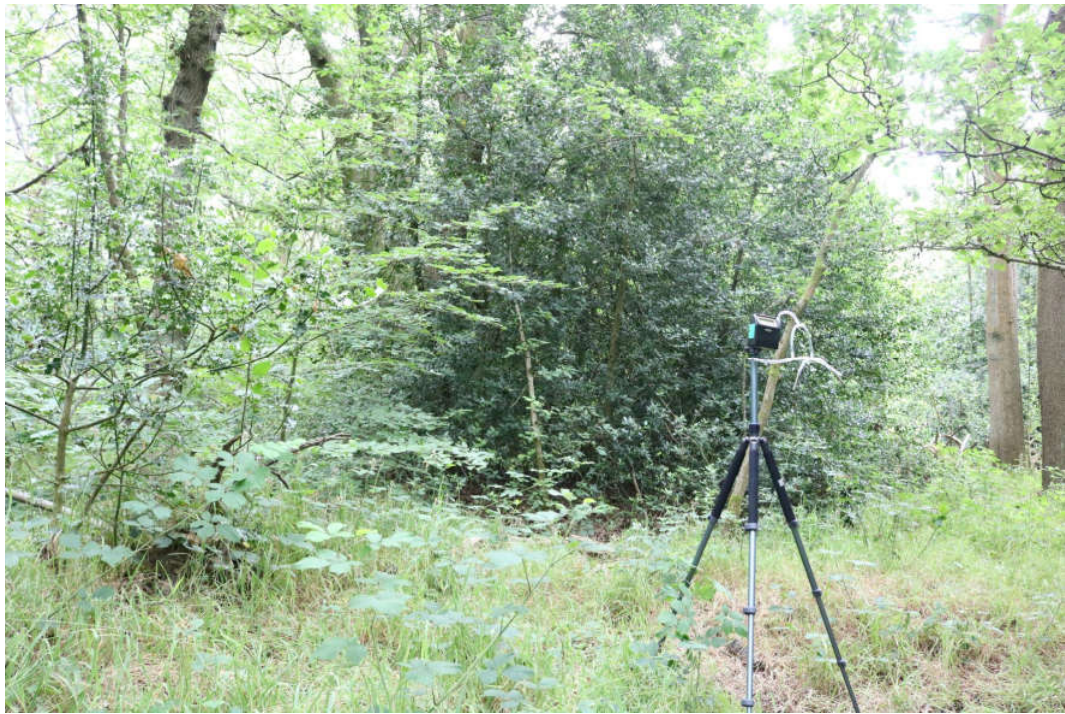
Figure 2. Collection of air sample set-up of tripod and pump in the forest.